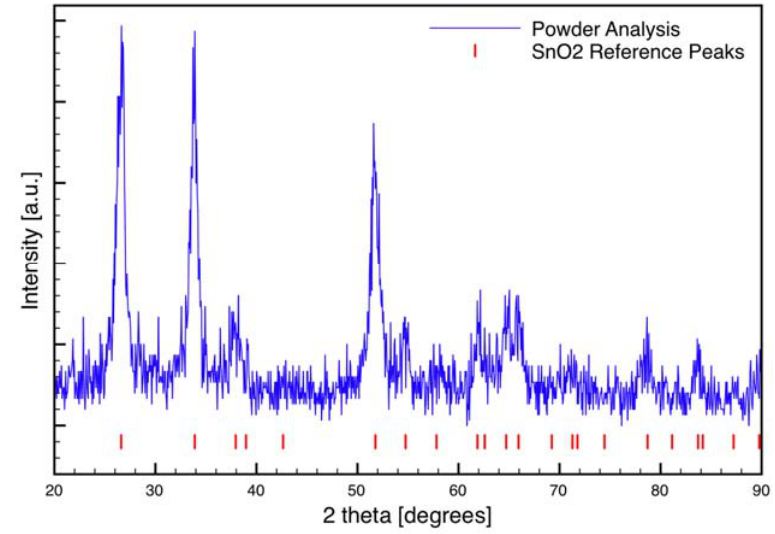
Figure 5. TEM image of SnO